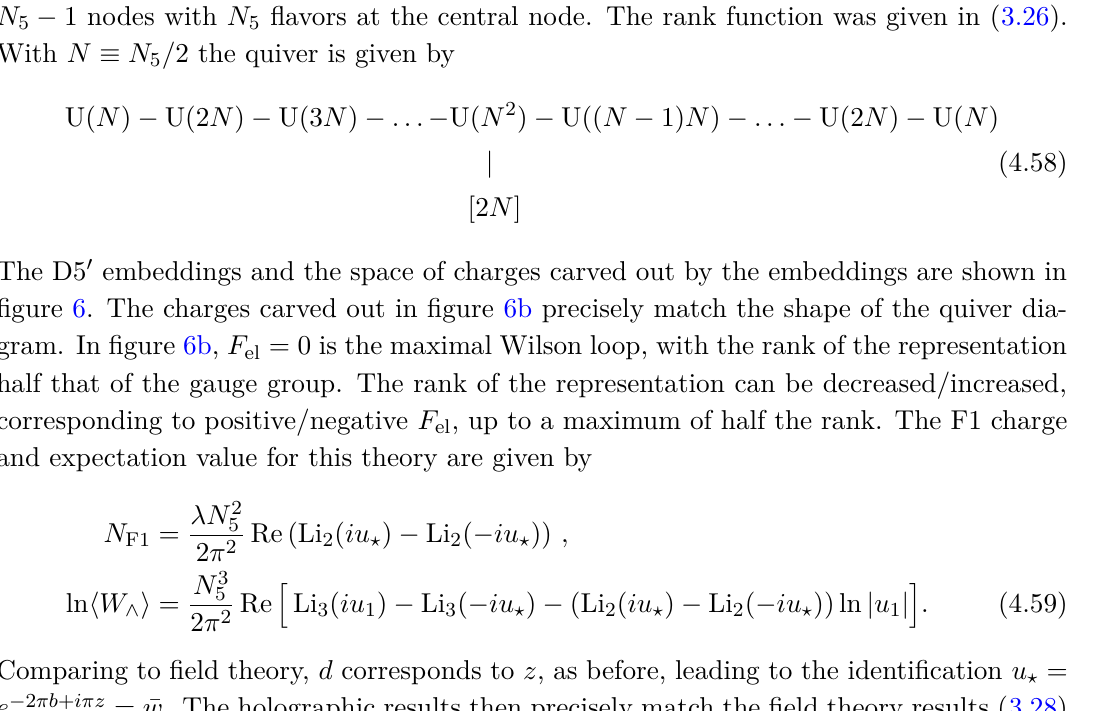
Figure 7. Left: Wilson loop embeddings for a balanced theory with two D5 poles, N (1) 1 N NS5 and σ 2 = iσ 1 = e 3 iπ/ 4 . Right: space of (D3,F1) charges carved out by the 2